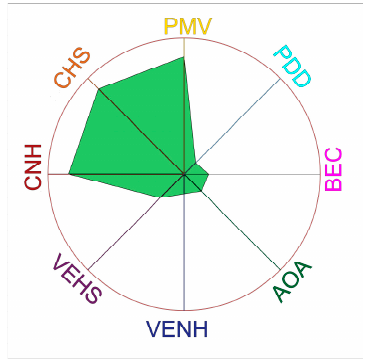
Figure 17. Normalized analysis comprehensive impact value.